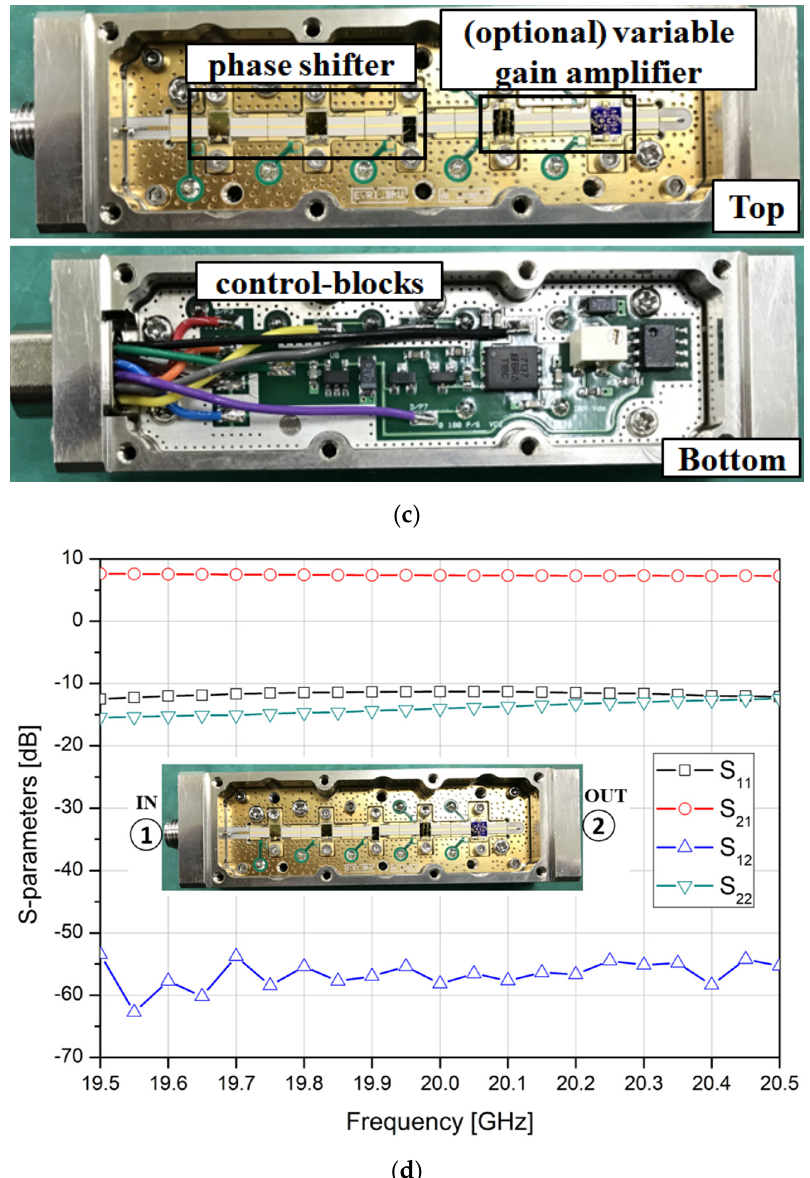
Figure 5. Implementation of ( a ) the single-waveguide BPF, ( b ) the cascaded BPF, and ( c ) the recursive path module and their ( d ) measured S-parameters.